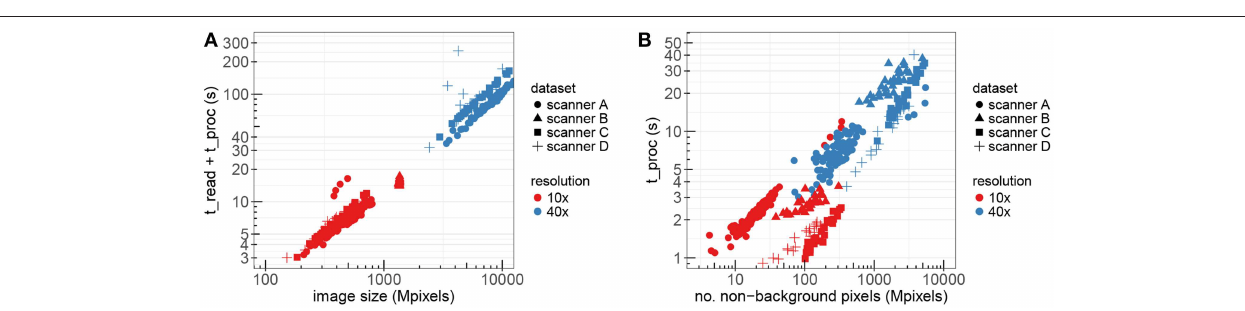
Frontiers in Medicine |